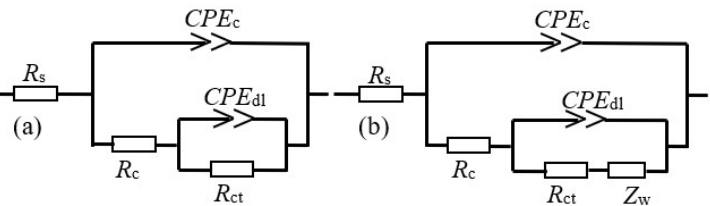
Figure 5. Nyquist and Bode curves of the coating sample, ( a , b ) the coating without composites filler, ( c , d ) the coating with 2 wt % composites filler.